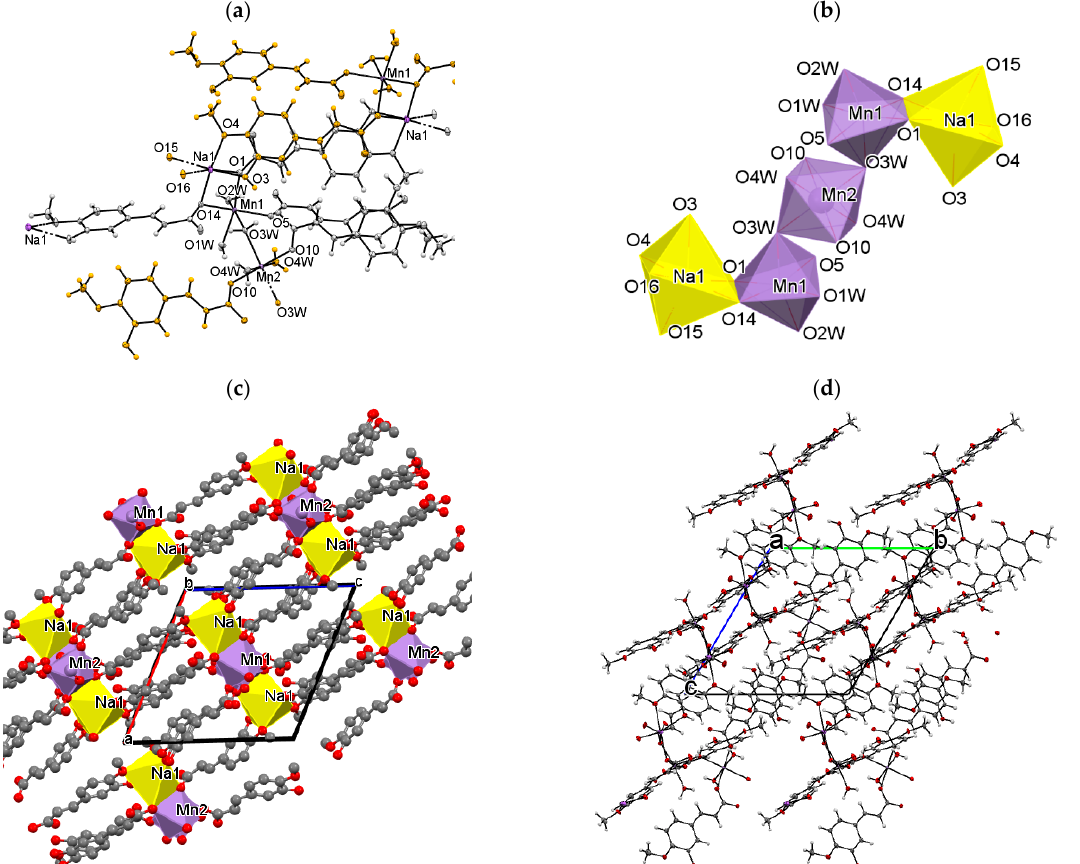
Figure 4. The part of the crystal structure of Mn(II)/Na(I) IFA presenting: ( a ) the coordination environment of Mn and Na cations in the crystal [Mn 3 Na 2 (C 10 H 7 O 4 ) 8 (H 2 O) 8 ] n (the asymmetric unit is marked grey); ( b ) coordination polyhedra of Mn1, Mn2, and Na1 ions; ( c ) crystal packing view down the b axis with polyhedral representation of the metal centers; ( d ) the 3D framework in view along the a